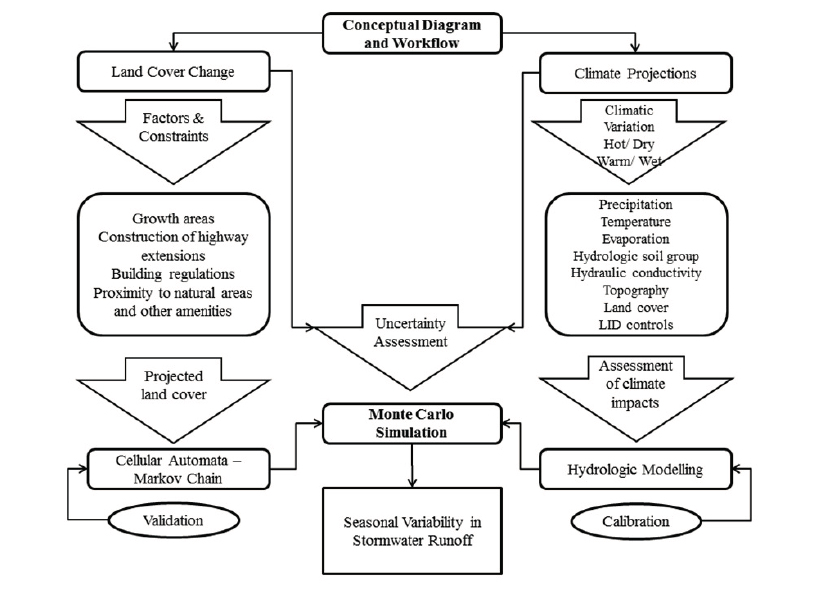
Figure 2. Conceptual diagram and